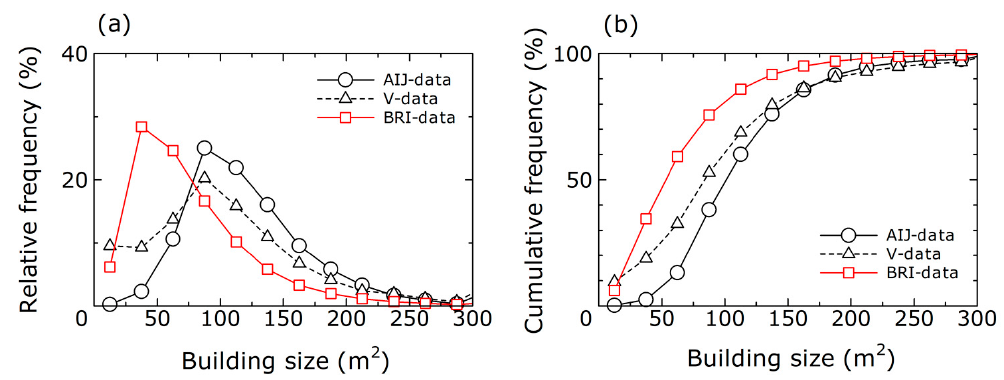
Figure 6. ( a ) Relative frequencies of the building size. ( b ) Cumulative frequencies of the building size.